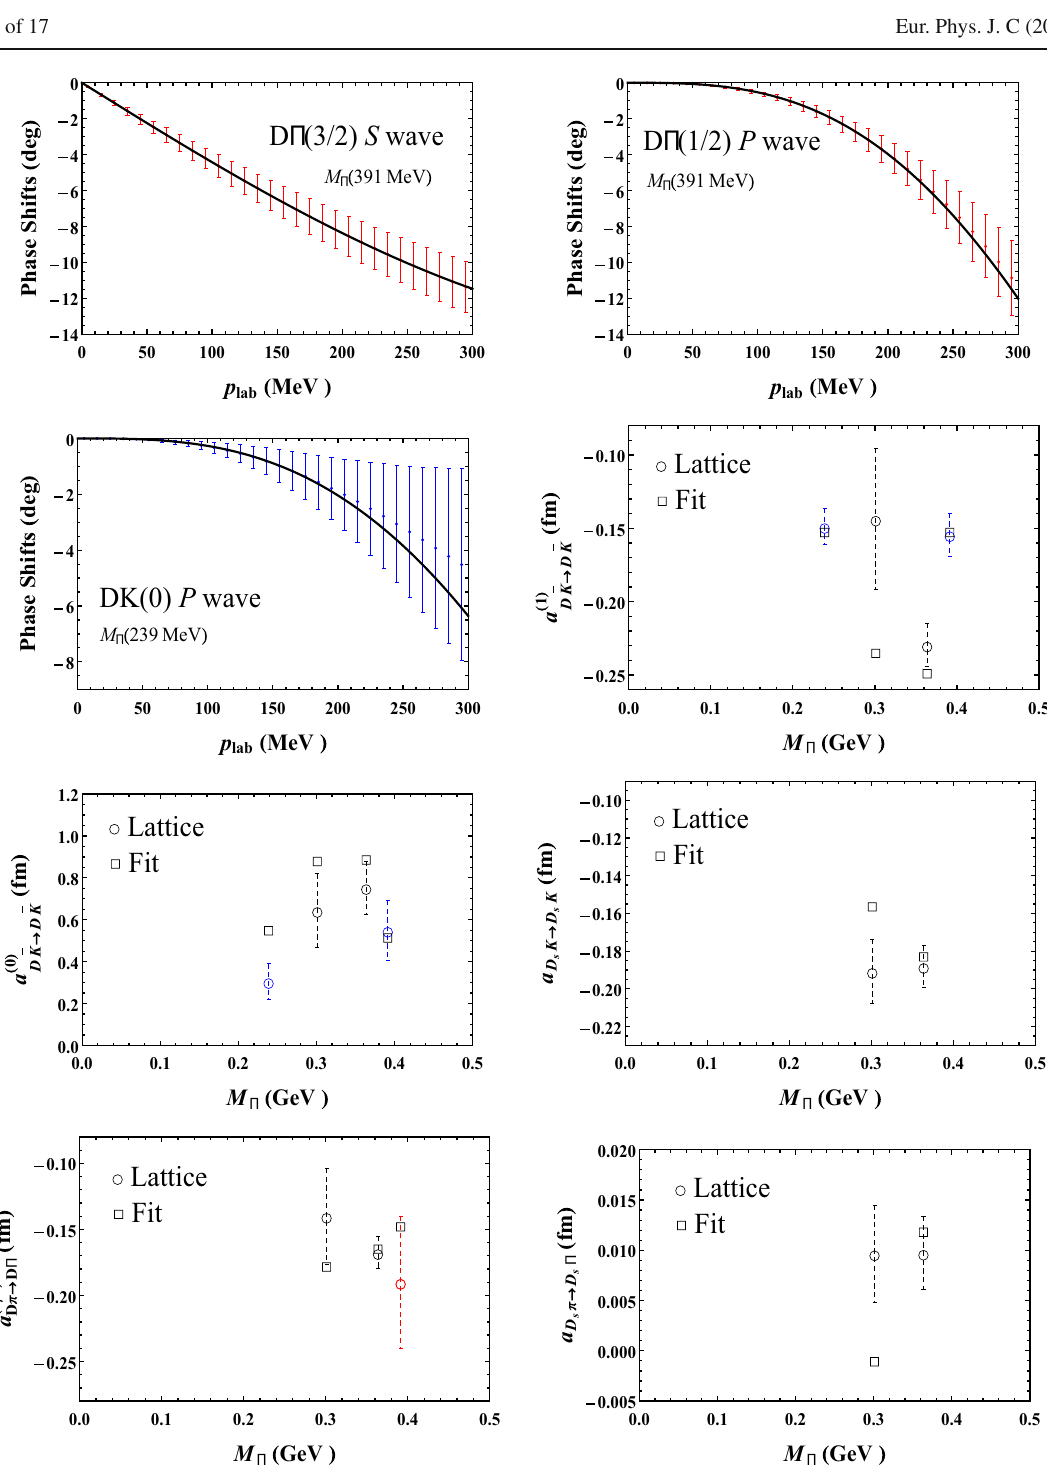
Fig. 2 Fits for the light pseudoscalar meson and D meson phase shifts and scattering lengths from various lattice data. The lattice phase shifts and scattering length with the red error bars in the D π( I = 3 / 2 ) S - wave, D π( I = 1 / 2 ) P -wave and a